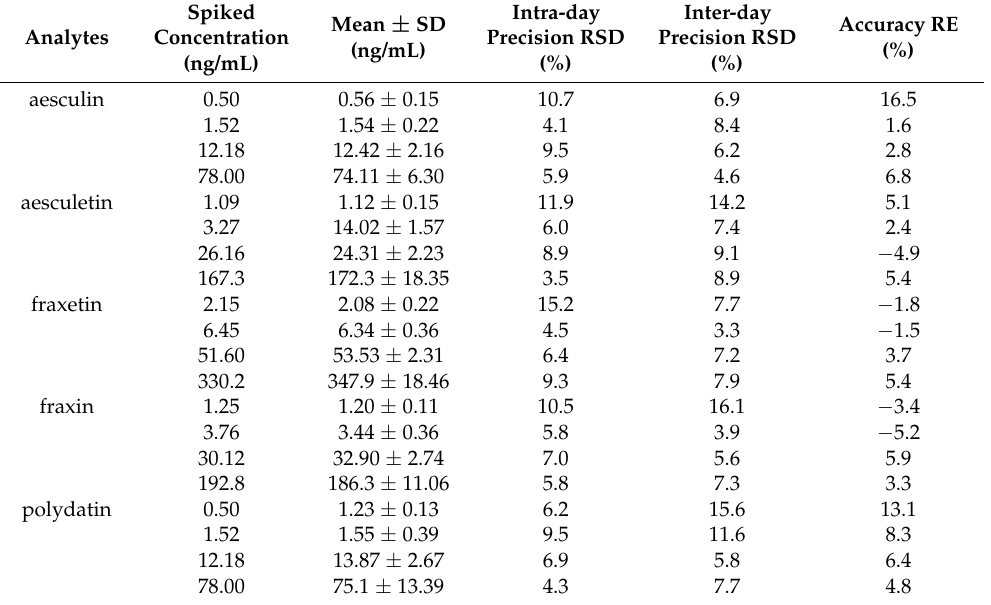
Table 3. Precision and accuracy of analytes at LLOQ and QC samples in beagle dog plasma (n = 6).